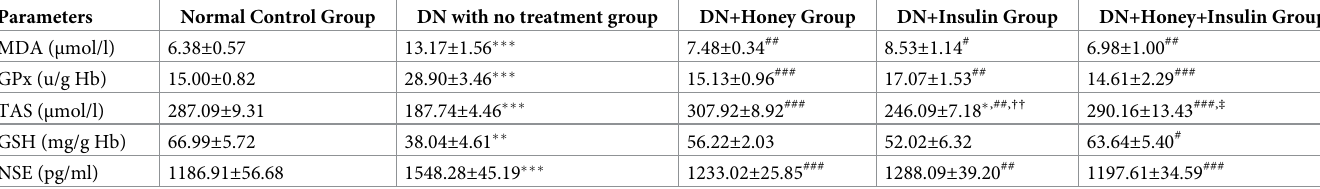
Table 3. Comparison of oxidative stress parameters and NSE in all the groups after six weeks of intervention. Parameters